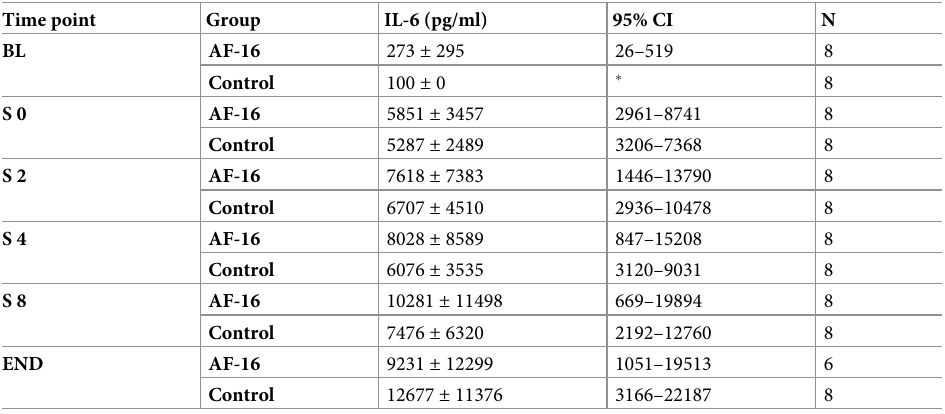
Table 7. IL-6 concentration in